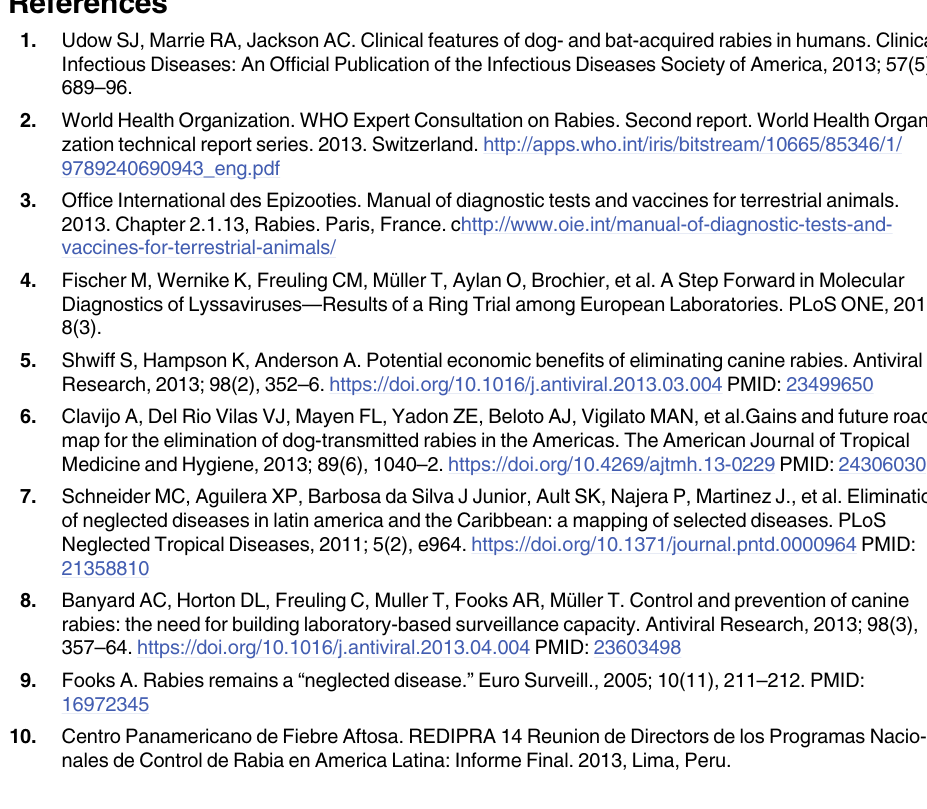
S2 Table. Responses to the laboratory practices assessment by